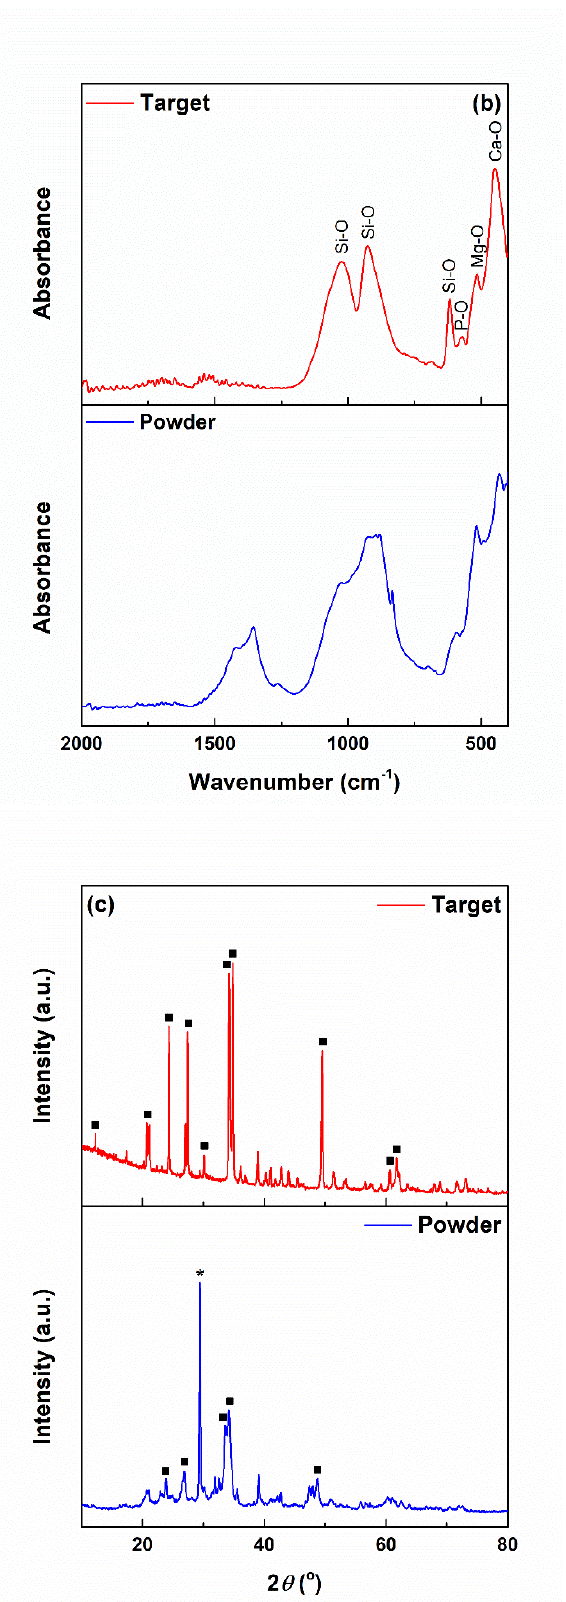
Figure 3. ( a ) EDX spectra, ( b ) FTIR spectra, and ( c ) XRD patterns of the powder and target. Square indicates Na 4 Ca 4 Si 6 O 18 , and star shows SiO 2 .